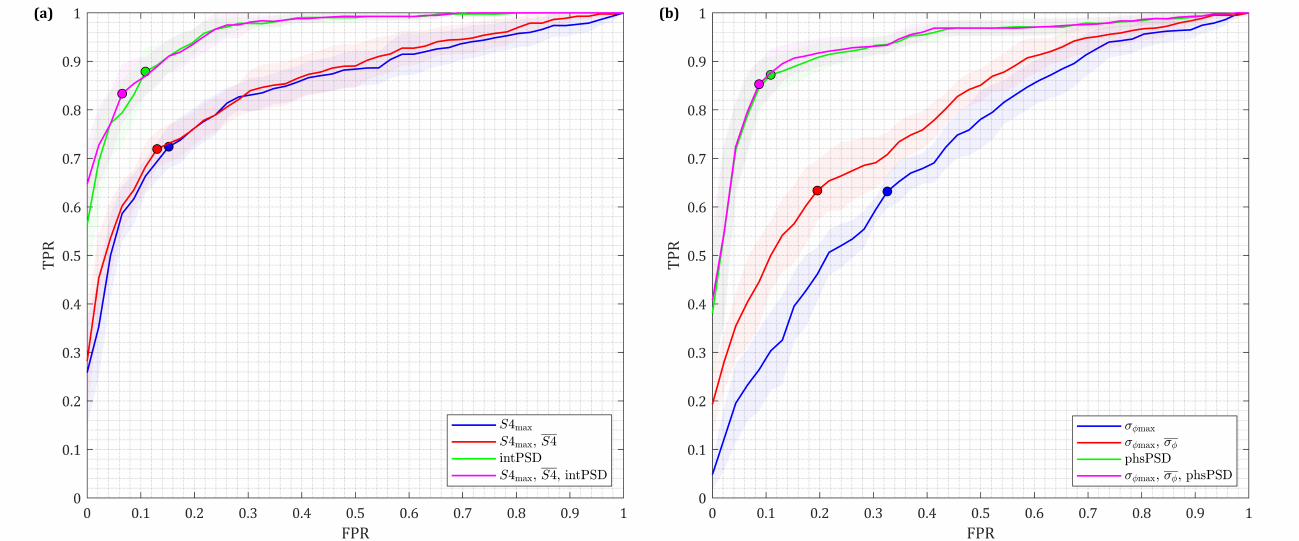
Figure 16. ROC curves obtained with Gaussian kernel for scenarios assuming ( a ) amplitude and ( b ) phase features. Shaded regions correspond to the 95% confidence